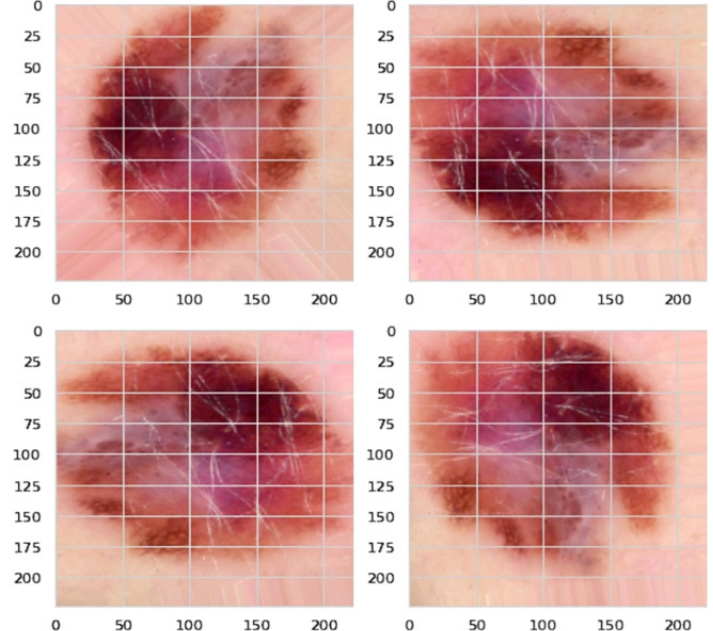
Figure 2. Data augmentation through image rotation.